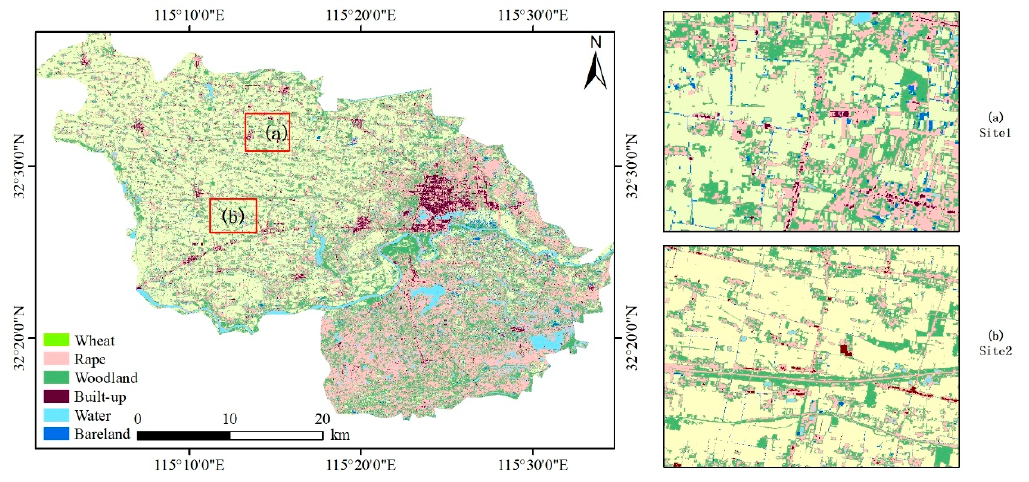
Figure 11. The mapping results of wheat, rape, woodland, built-up, water and bareland in Huaibin County.